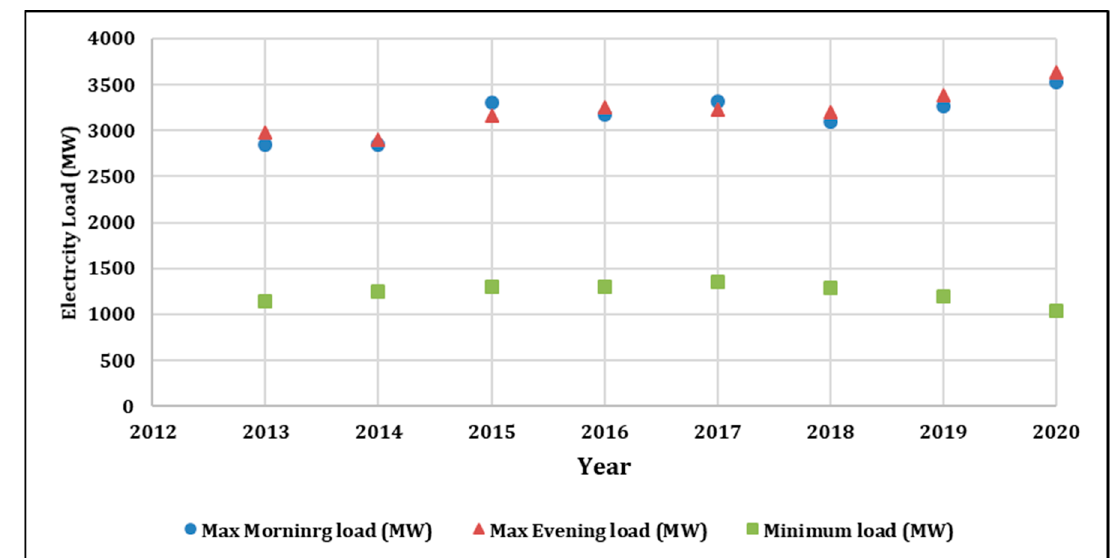
Figure 3. Peak load of the interconnected system (2013–2020).